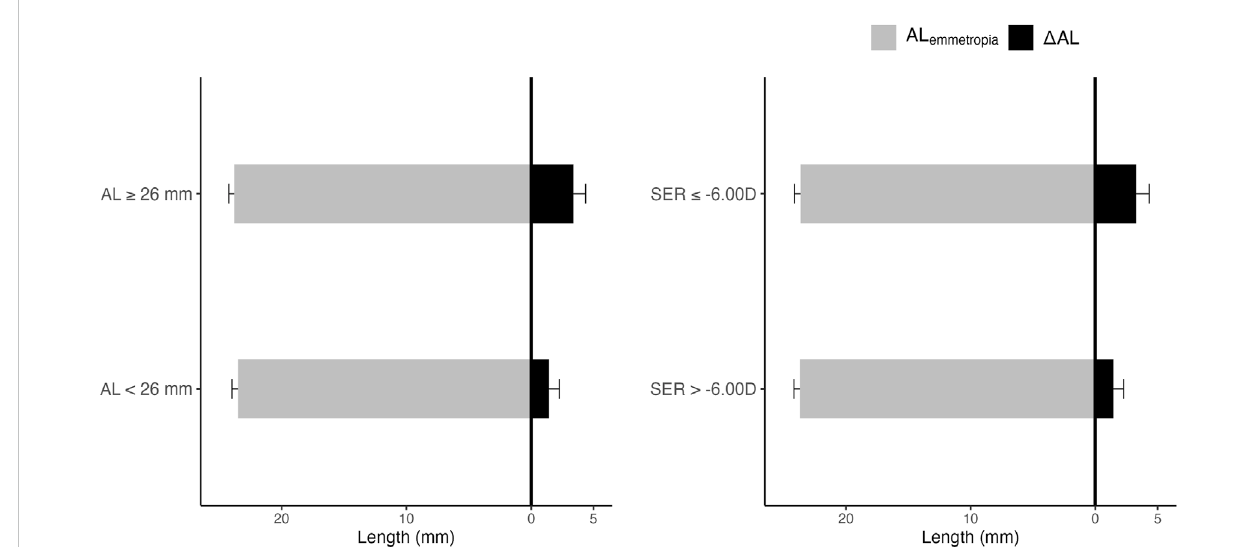
FIGURE 3 AL,AL emmetropia ,and Δ AL.TheleftpanelofFigure3showslevelsofAL emmetropia and Δ ALinsubjectswithAL < 26 mmandAL ≥ 26 mm.Therightpanel of Figure 3 shows levels of AL emmetropia and Δ AL in subjects with SER > − 6.00D and SER ≤ − 6.00D. The grey area represents AL emmetropia . The black area represents Δ AL. Abbreviations: AL, Axial length; SER, Spherical equivalent error.